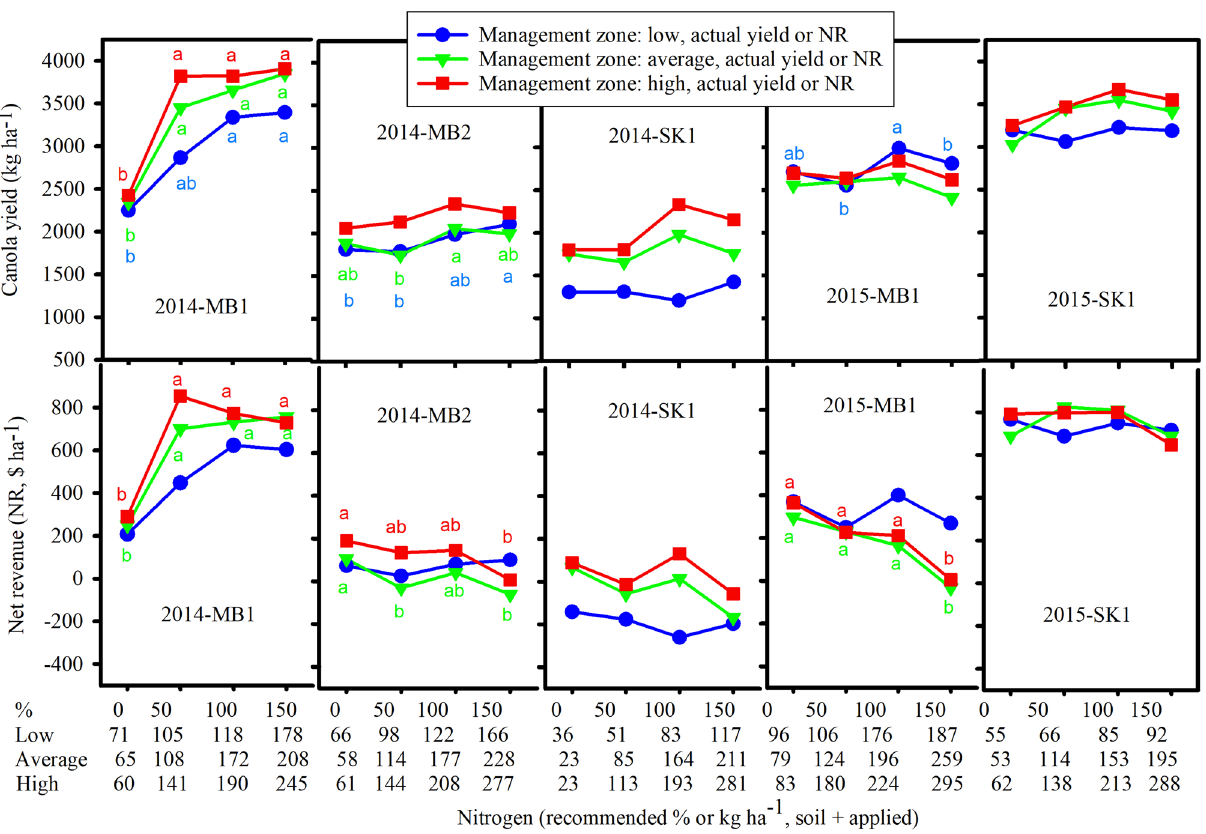
Figure 2. Response of canola yield and net revenue to nitrogen fertilizer treatments in three canola management zones at 2014-MB1, 2014-MB2, 2014-SK1, 2015-MB1 and 2015-SK1. Means followed by the same letters for each canola management zone are not significant ( p > 0.05) (SigmaPlot, vision 14, https ://systa tsoft